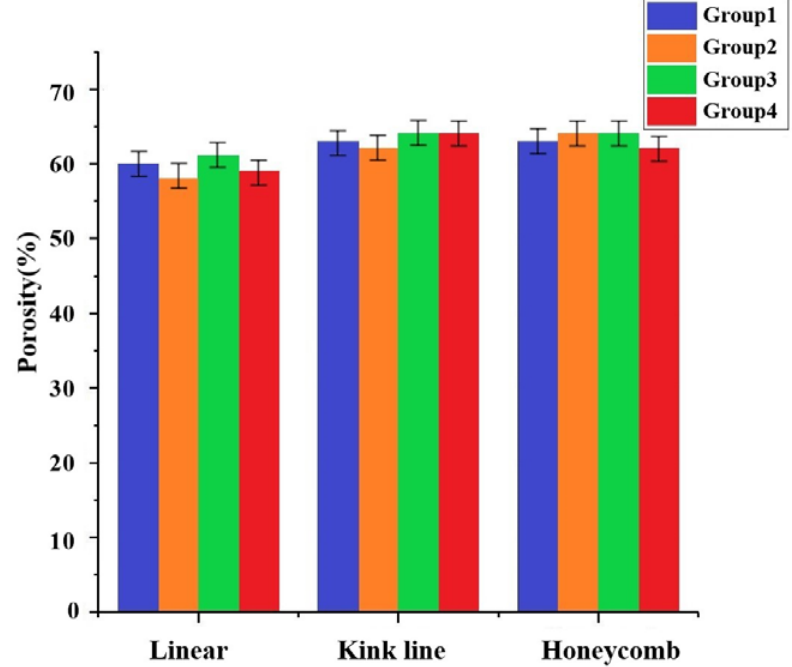
Figure 13. Porosity of zirconia samples with different internal structures.